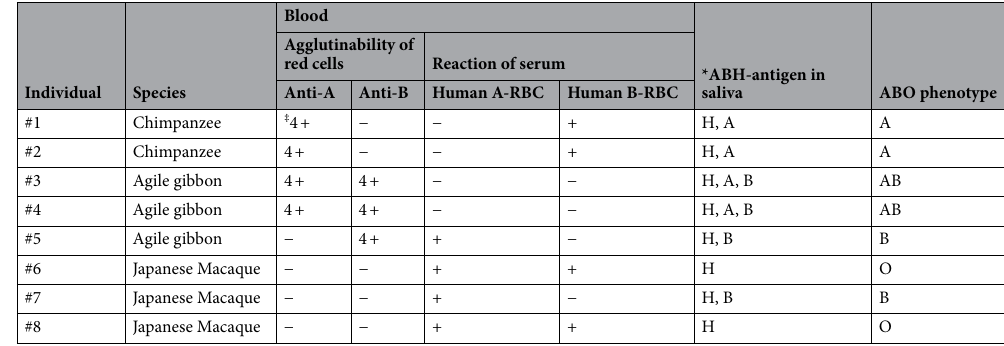
Table 1. Summary of serological results obtained using samples from individual primates. *Presence of ABH- antigens was examined by testing saliva for its ability to inhibit anti-A, anti-B and anti-H reagents. ‡ 4 + denotes complete agglutination